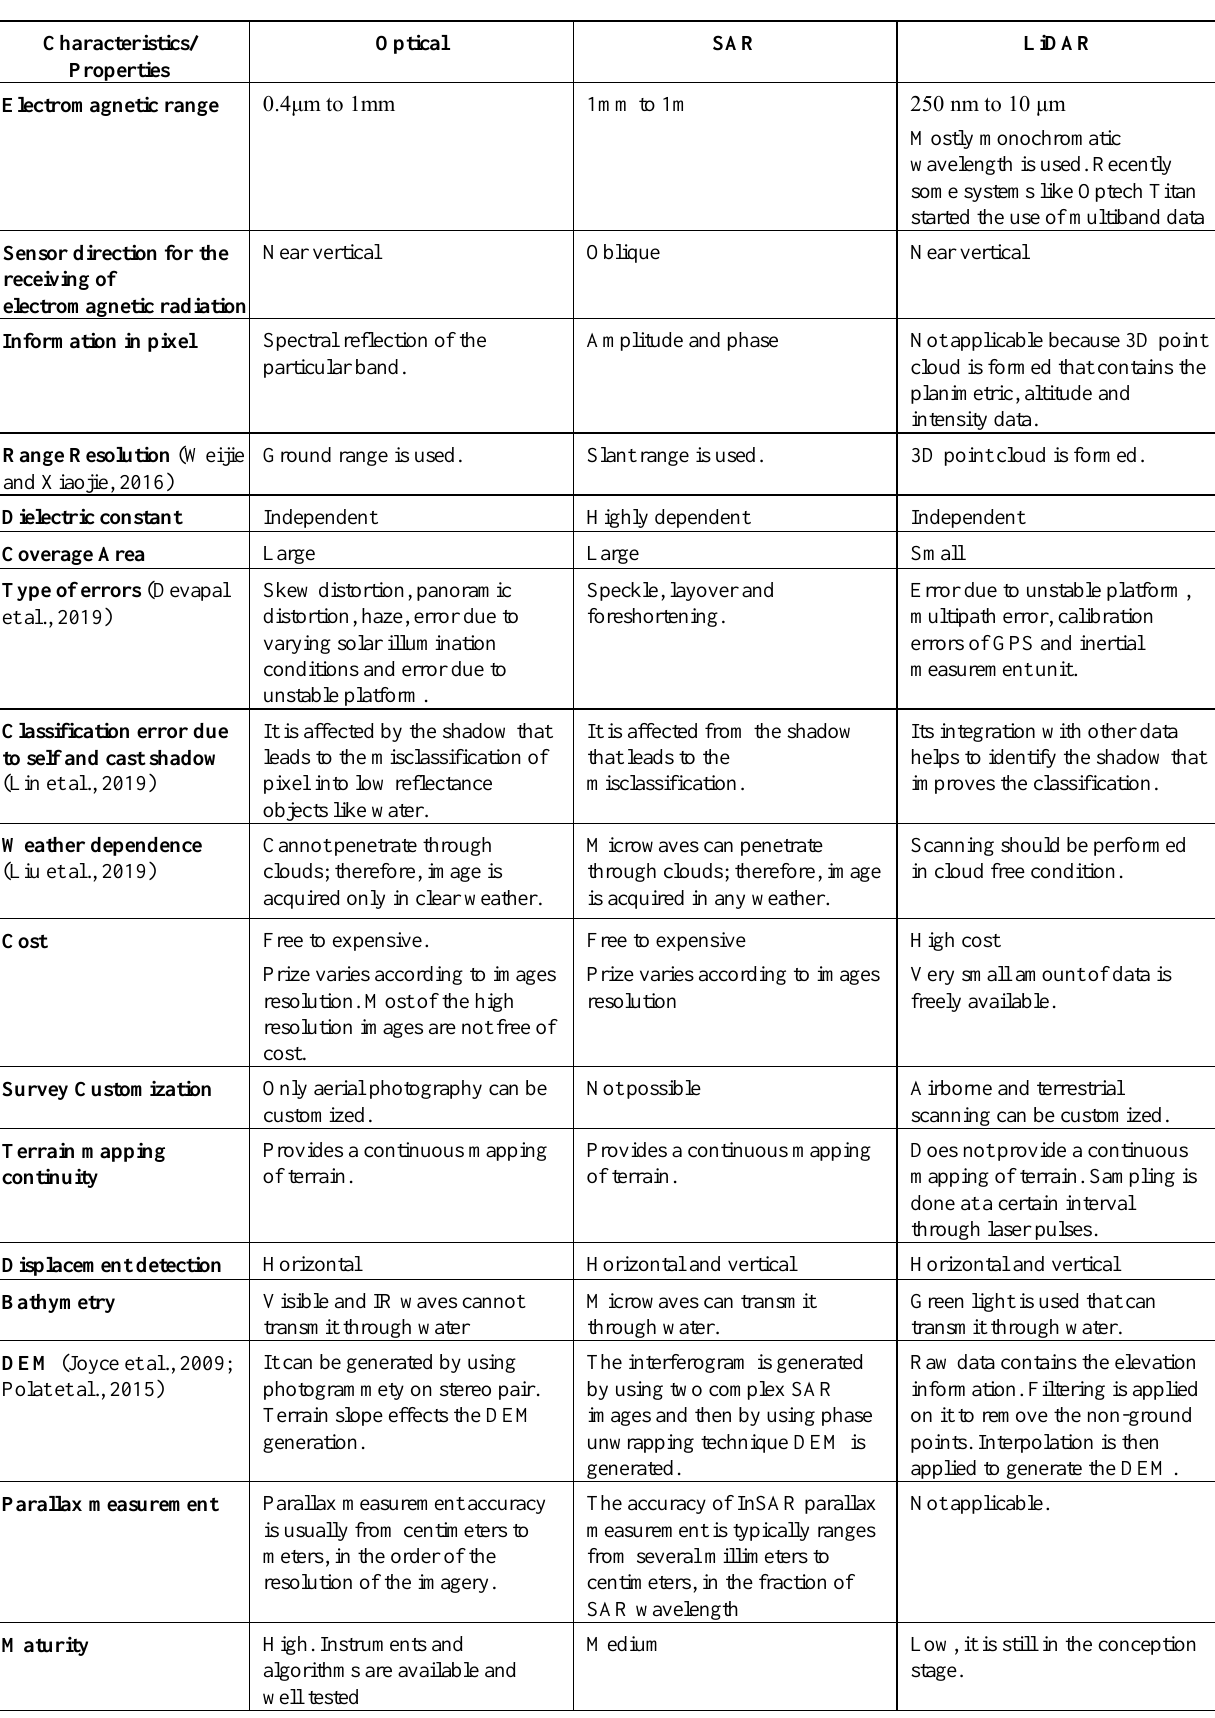
Table 1. Comparison between optical, SAR and LiDAR imaging techniques on the basis of technical specification and